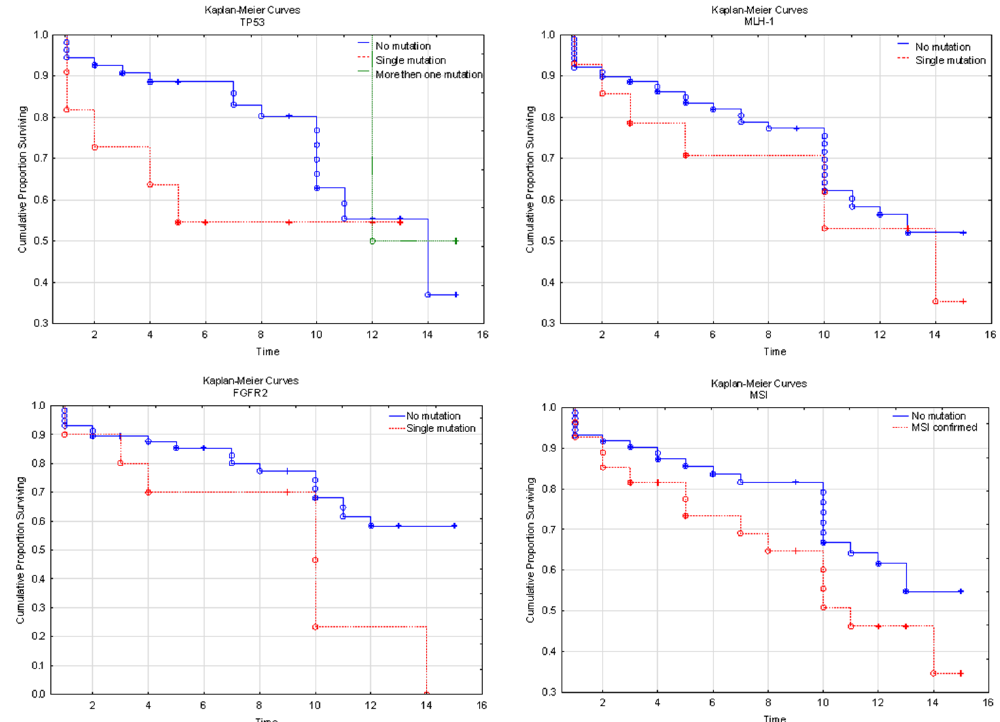
Figure 3. The Kaplan-Meier curves. We noticed only the strong impact of FGFR-2 mutation on OS ( p < 0.01). A visualization of discovered mutations and their frequency according to the studied case. All cases of beta-catenin contribution overlaps with the AKT-mTOR Pathway.